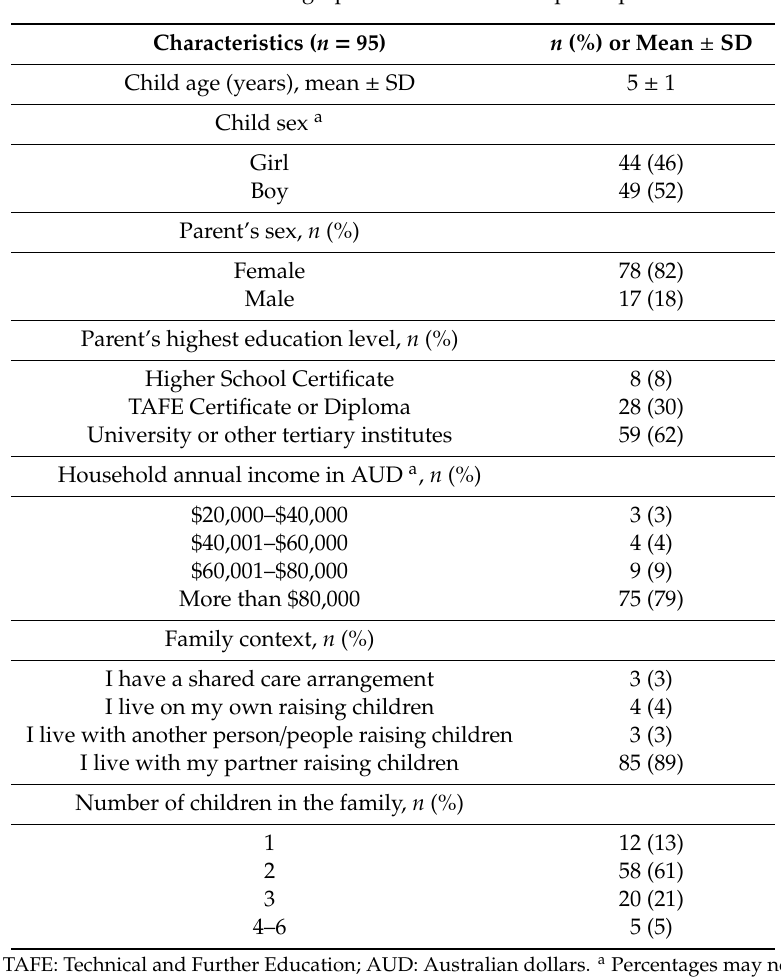
Table 2. Sociodemographic characteristics of